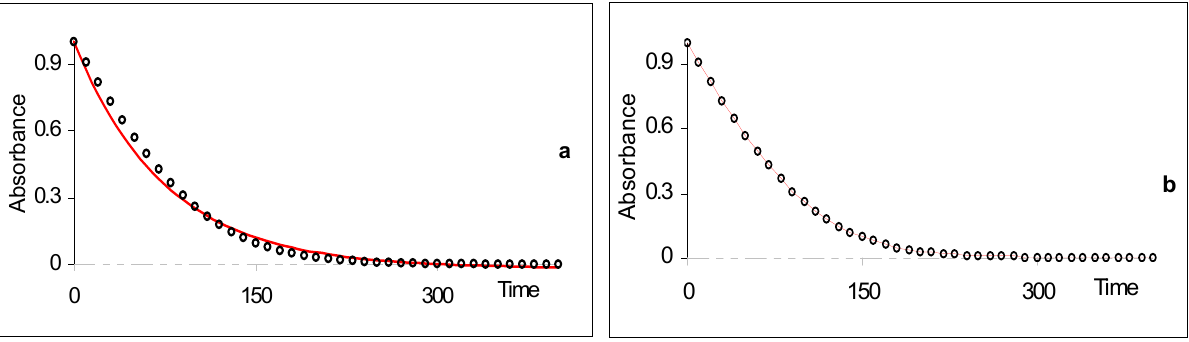
Figure 4. Comparison between fitting simulated RK data to (a) monoexponential and (b) analytical model Eq.19a [reprinted from Ref. 93 with permission of the Journal of Photochemistry and Photobiology: A